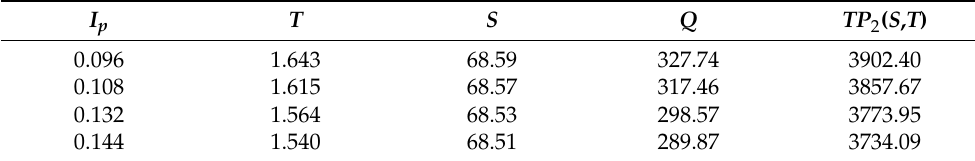
Table 13. Impact of interest paid